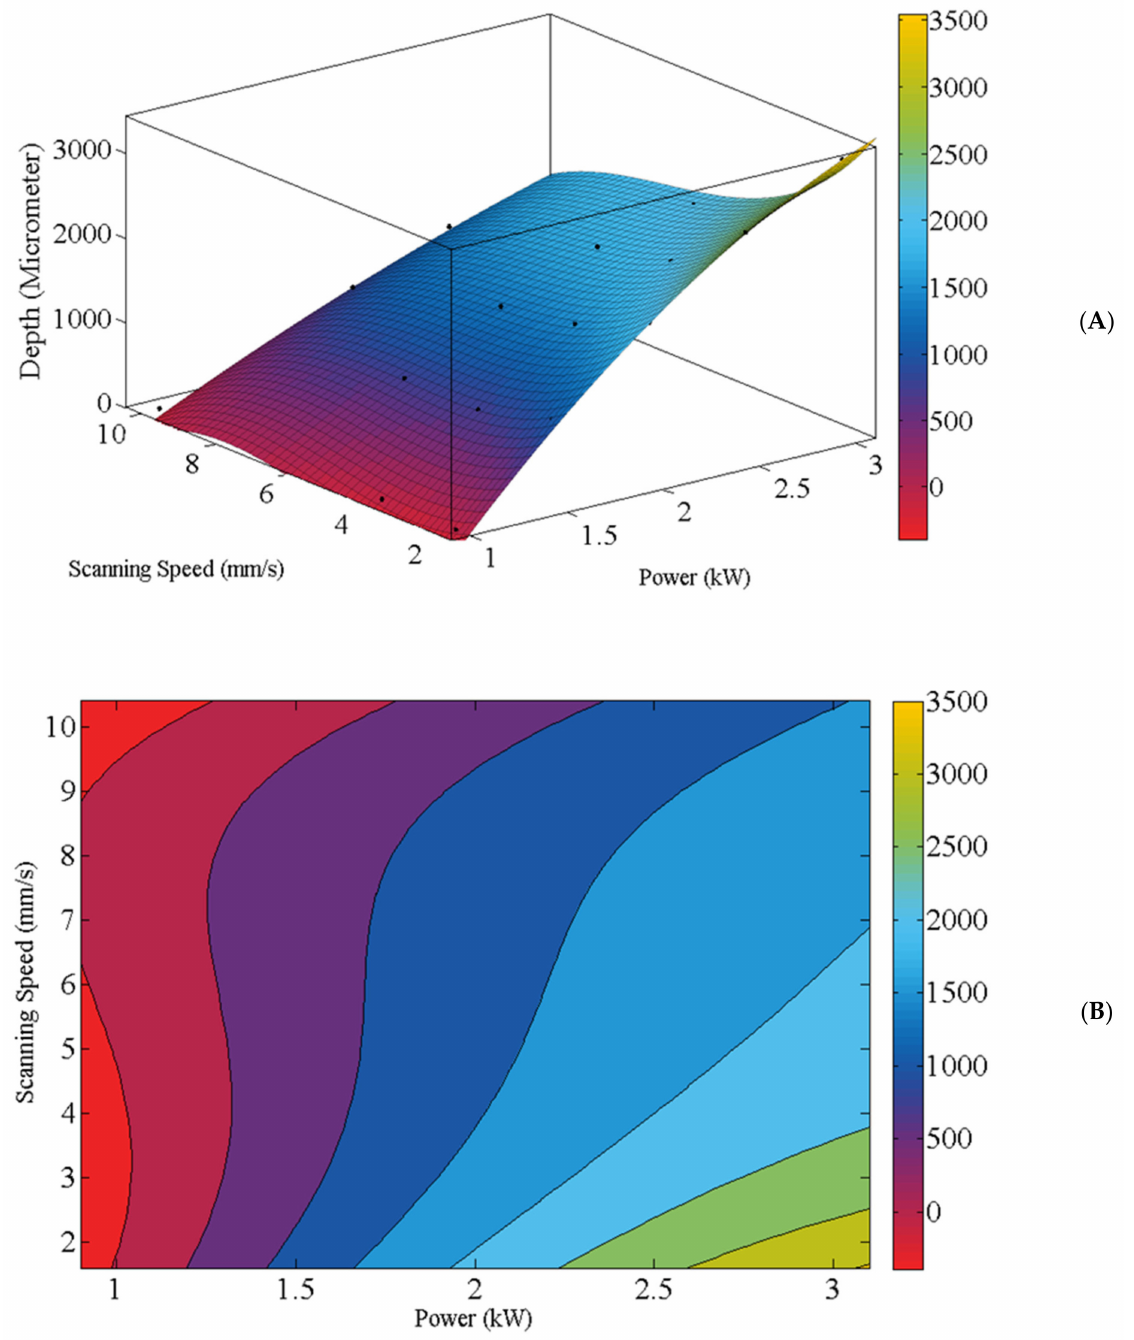
Figure 13. ( A ) The best curved surface (R-square: 0.9904; Adjusted R-square: 0.952; RMSE: 0.1674) and ( B ) contour plot for the depth (in micrometers) of deposited clad regarding the combination of the laser power and scanning